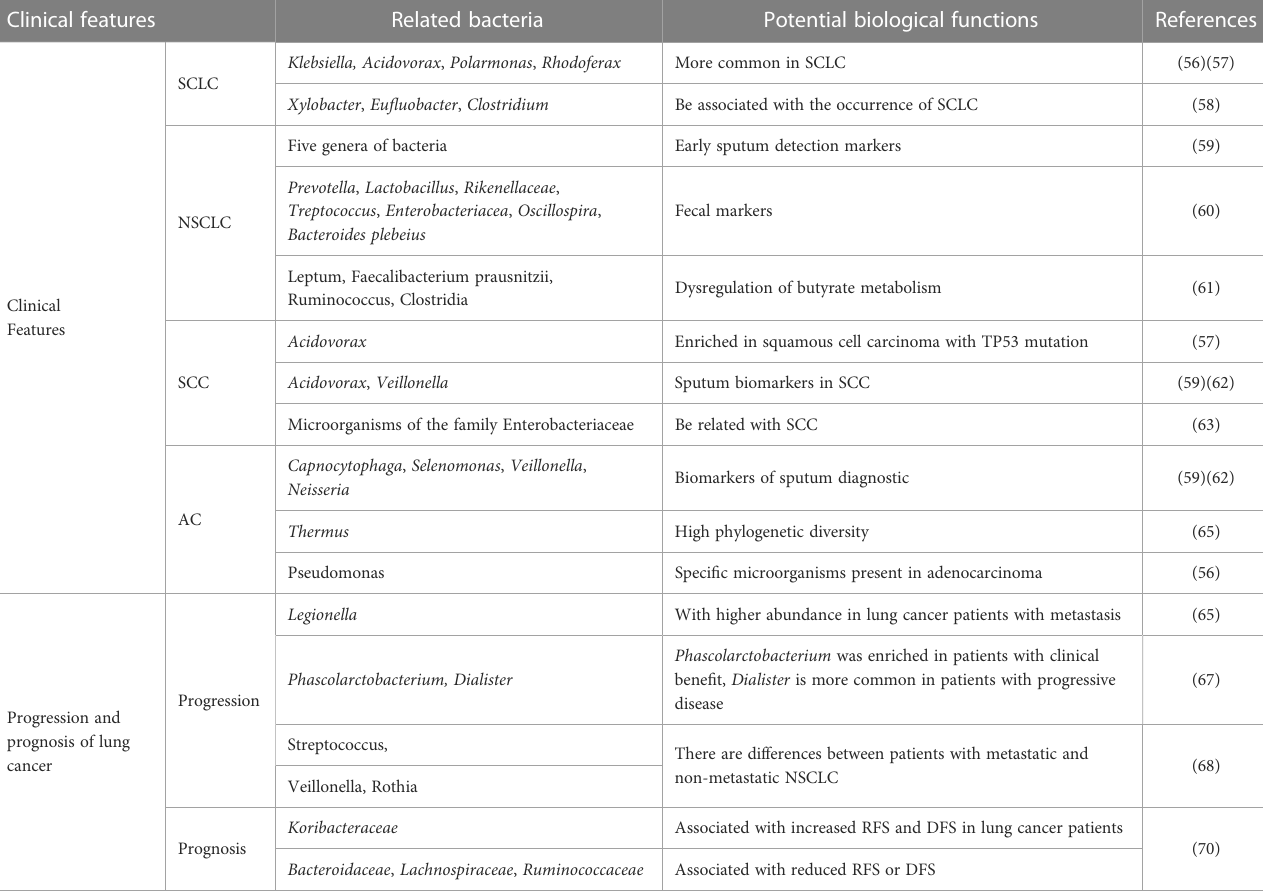
TABLE 1 Relationship between microbiome and clinical features of lung